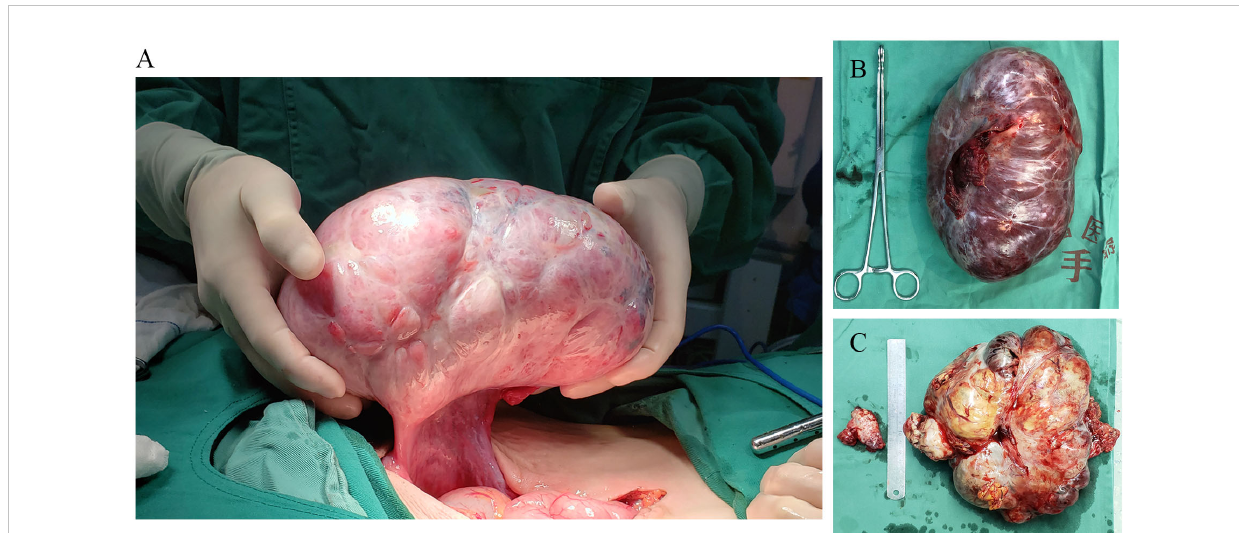
FIGURE 2 Representative samples of ovarian tissues from patients undergoing ovariectomy. (A, B) Patients were subjected to palliative resection of ovarian tumor alone. The ovarian tumor was large and kidney-shaped, with a complete capsule and smooth appearance without mass deposition. (C) Bilateral gross ovarian specimens from patients subjected to metastatic ovarian tumor resection and contralateral prophylactic oophorectomy. (left) Contralateral prophylactically resected ovarian tissue, (right) KT